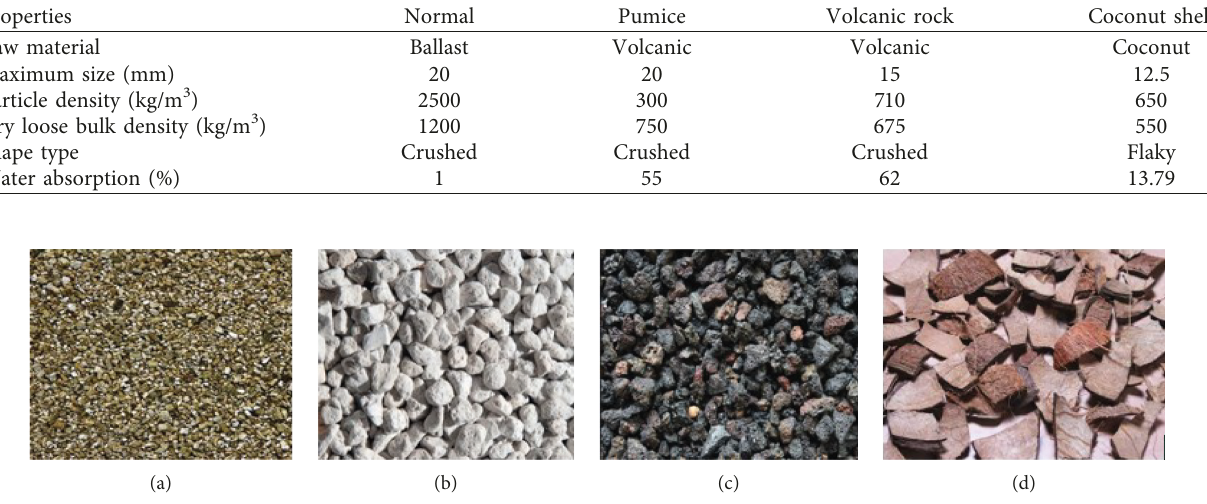
Table 4: Properties of normal and lightweight coarse aggregates.